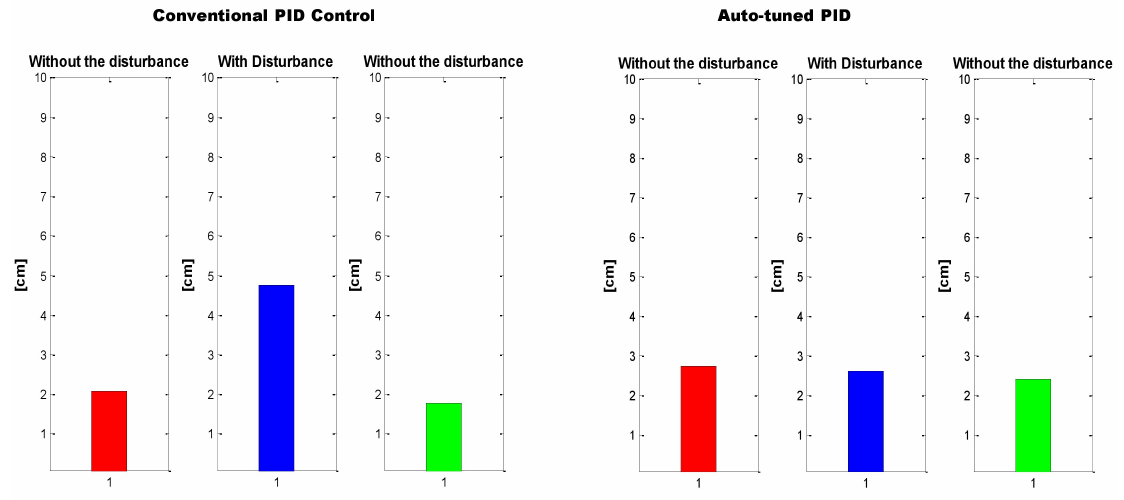
Figure 23. MSE: Conventional PID Controller ( left ) vs. auto-tune PID ( right